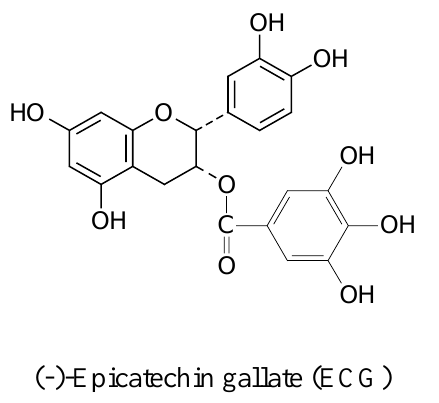
Figure 1. Phenolics in tea